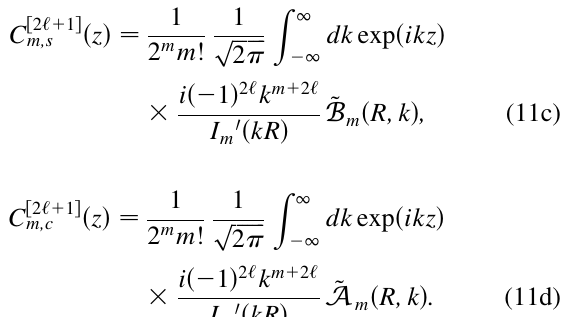
(cid:4) R; k (cid:5) versus k 0 ;(cid:4)